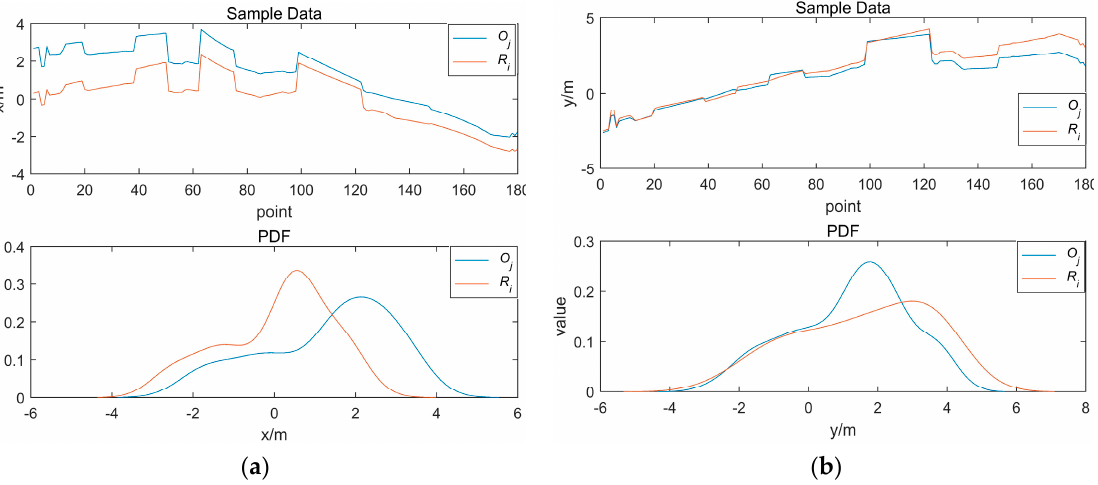
Figure 9. Sample data distribution and probability density function of data sets O j and R i : ( a ) x -axis; ( b ) y-axis.